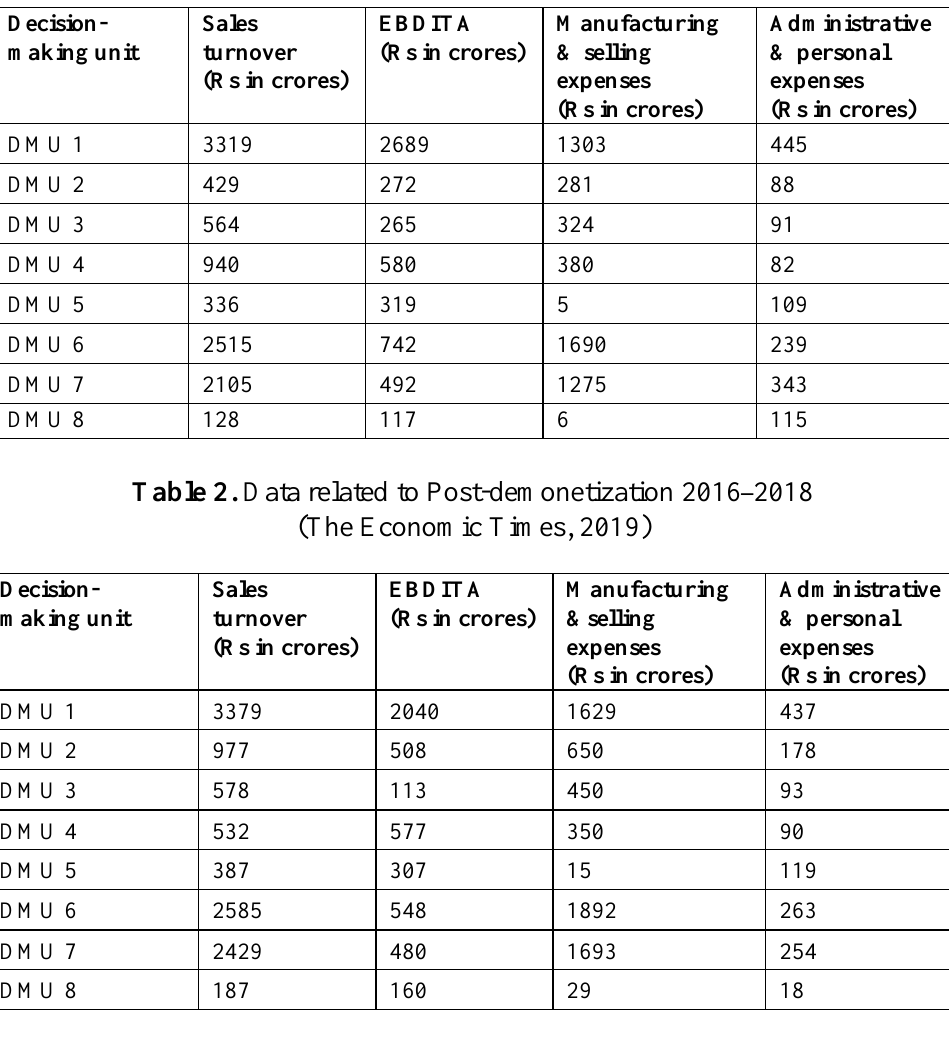
Table 1. Data related to Pre-demonetization 2014 – 2016 (The Economic Times, 2019)